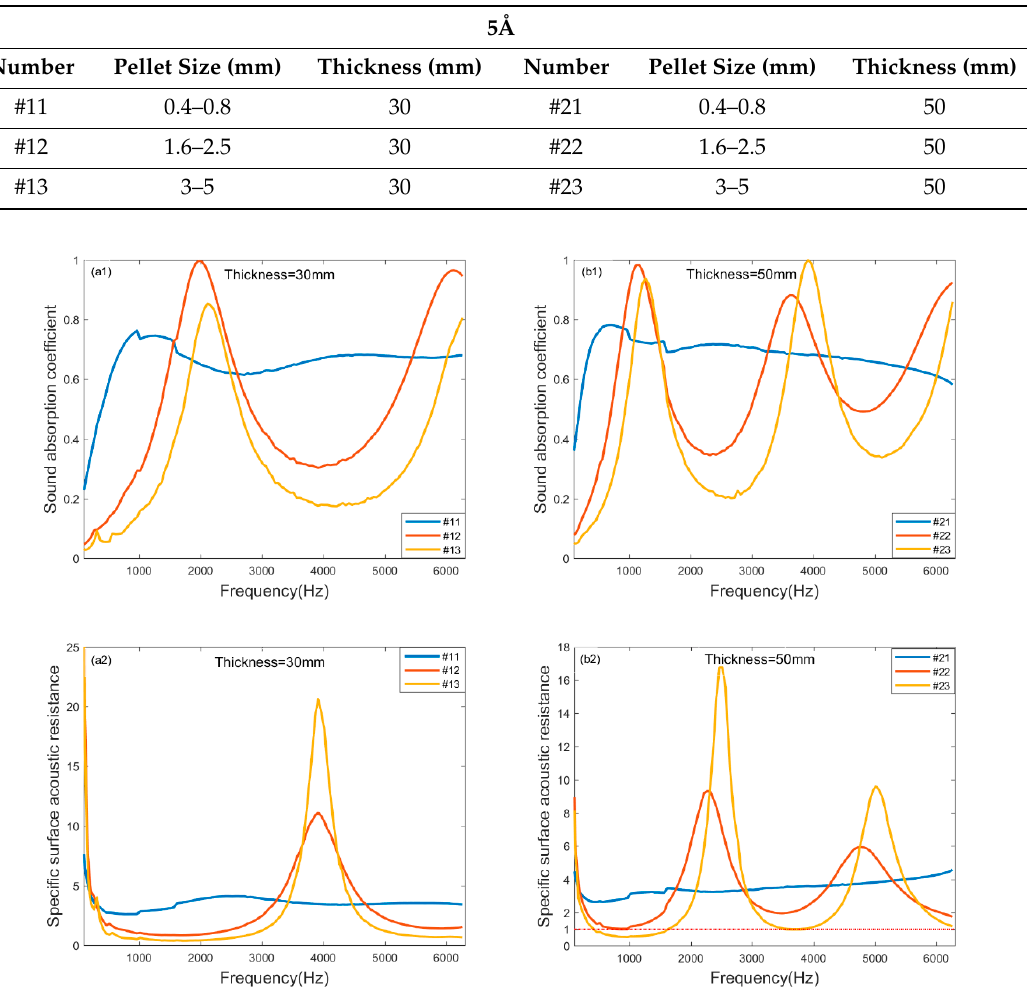
Table 3. Samples of molecular sieve pellets with different pellet sizes.